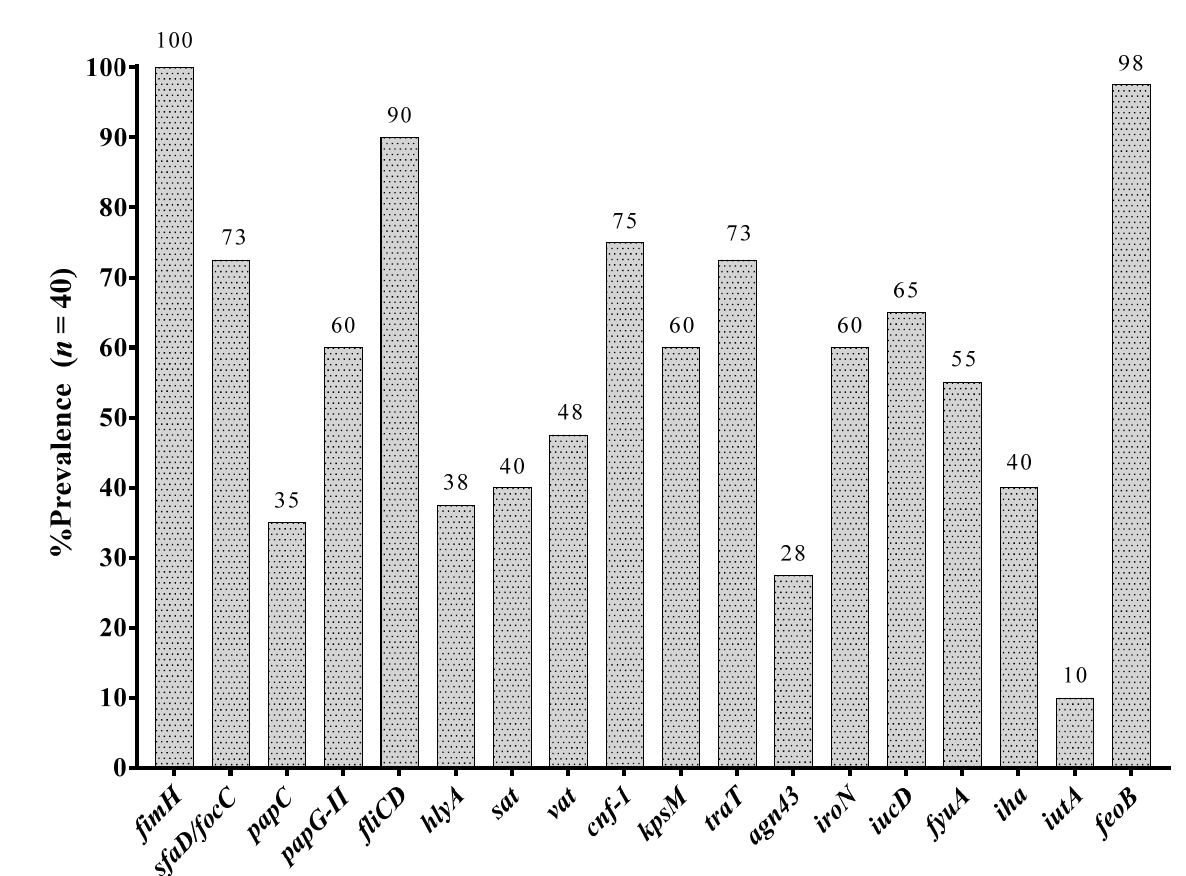
Figure 2. Prevalence of 18 virulence genes in analyzed clinical isolates of UPEC. fimH : Fimbrial Adhesin of type 1 pilus; sfaD/focC : S fimbriae minor subunit/F1C fimbriae chaperone; papC : Type P pilus chaperone; papG-II : Type P pilus Adhesin allele 2; fliCD : Flagellin subunit/flagellar cap; hlyA : α -hemolysin; sat : Autotransporter secreted toxin; vat : Vacuolating autotransporter toxin; cnf-1 : Necrotizing cytotoxic factor; kpsM : Capsular variant; traT : Serum resistance protein; agn43 : 43 antigen; iroN : Salmochelin siderophore receptor; iucD : Aerobactin; fyuA : Yersiniabactin; iha : Bifunctional enterobactin receptor/adhesin protein; iutA : Ferric aerobactin receptor; feoB : Ferrous iron transport protein B. Table 3. Common virulence profile in analyzed clinical isolates of